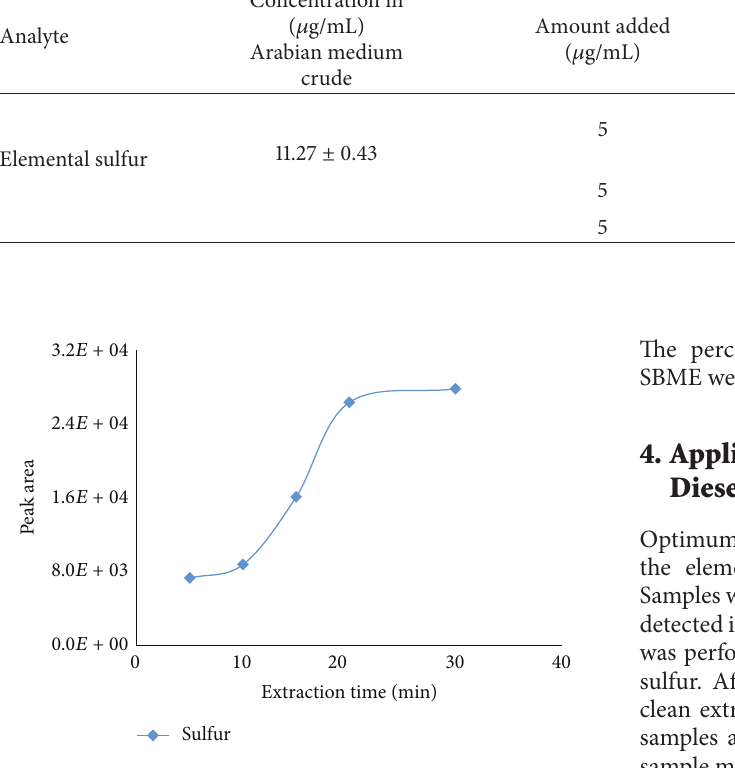
Figure 3: Influence of the SBME simultaneous extraction and derivatization